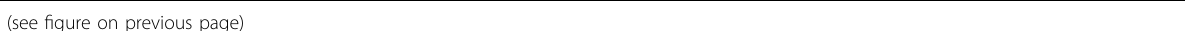
Fig. 7 GRHL1 knockdown inhibits the tumor growth in the xenograft model. A Upper panels: The knockdown ef fi ciency of A549 stable cell lines detected by western blots. Bottom panels: A549-WT and A549-shGRHL1 cells were trypsinized, counted, and seeded in 6-well plates with 500 cells per well. After 10 days, cells were fi xed and stained with crystal violet. Representative wells were photographed and shown. B A549-WT and A549- shGRHL1 cells were cultured in RPMI 1640 with 10% FBS for indicated times, and then cells were fi xed in 3.7% formaldehyde and stained with 0.1% crystal violet. Dye was extracted with 10% acetic acid and the relative proliferation was determined by the absorbance at 595 nm. Data represent the average of three independent experiments (mean± SD). *** P < 0.001. C Soft agar assay. A549-WT cells or A549-shGRHL1 stable cells were suspended with RPMI 1640 supplemented with 10% FBS and 0.3% agarose followed by plating on top of a solidi fi ed layer of RPMI 1640 supplemented with 10% FBS and 0.5% agarose. Cultivated for 2 weeks. The photographs of colonies in soft agar assay. Magni fi cation of upper fi gures is ×40, scale bars: 400 μ m. The magni fi cation of lower fi gures is ×200, scale bars: 100 μ m. D , E A549-WT and A549-shGRHL1 cells were cultured in RPMI 1640 with 10% FBS for the indicated time, cell cycle analysis was done by fl ow cytometry. The inserts show the quanti fi cation of the cell cycle analysis. F – J Wide-type A549 cells and A549-shGRHL1 mutant cells (1 × 10 7 ) were subcutaneously injected into the fl anks of nude mice. Four weeks later, tumors were dissected out, photographed ( F ), and their weights and volumes measured. The p value was calculated by paired t test ( G , H ). The xenograft tumors was lysed. Protein expression was assessed by western blotting using the indicated antibodies( I ). Photomicrographs of hematoxylin-eosin (HE) staining for tumors induced by wide-type A549 cells and A549-shGRHL1 cells. Magni fi cation of upper fi gures is ×100, scale bars: 200 μ m. The magni fi cation of lower fi gures is ×200, scale bars: 100 μ m( J ). K Immunohistochemical staining in tumors induced by wide-type A549 cells and A549- shGRHL1 cells for PCNA and TTF1. Magni fi cation is ×200, scale bars: 100 μ